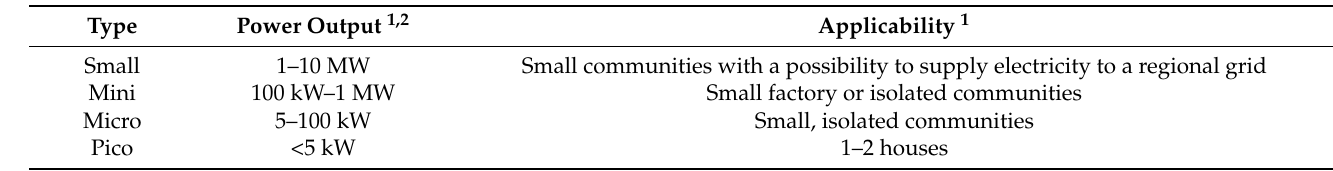
Table 4. Classification of small-scale hydropower systems based on power capacity and the potential applications to a range of